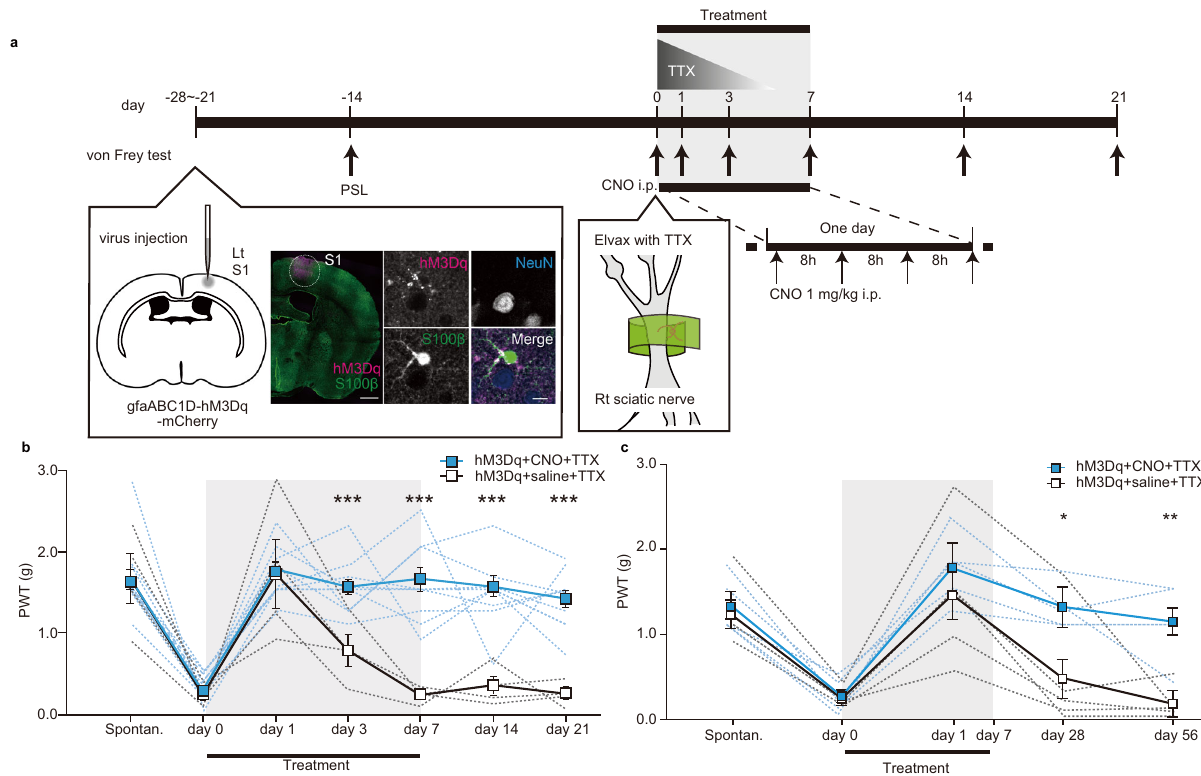
Fig. 2 Chemogenetic activation of targeting S1 astrocytes combined with transient nerve block reverses mechanical allodynia-like behaviour. a Schematic of the experimental schedule. The start of CNO-TTX (or control) treatment was designated as “ day 0 ” . Injection of gfaABC1D-hM3Dq- mCherry AAV into the PSL-contralateral S1 was performed between day − 28 to day − 21. Immunohistochemistry con fi rmed widespread expression (see Supplementary Fig. 6 for quanti fi cation) of hM3Dq (mCherry tag) in S1 astrocytes (S100 β staining) with no off-target expression in S1 neurons (NeuN staining). 1 mg/kg CNO (black bar) was injected at 8-hourly intervals from day 0 to day 7 (21 injections in total). PSL surgery, measurement of mechanical paw withdrawal thresholds (arrows), and TTX administration (graded triangle) were performed as in Fig. 1. Left fi gure scale bar = 500 μ m. Right fi gure scale bar = 10 μ m. b , c Graphs plotting mechanical paw withdrawal thresholds as mean ± SEM at various time-points before PSL (Spontan.) and before (day 0), during (day 1 – day 7), and after (day 8 onwards) the TTX with CNO treatment period (grey shading) or control TTX with saline treatment. For all graphs separately, statistical signi fi cance was tested using a two-way repeated measures ANOVA, followed by Bonferroni post hoc tests comparing treatment cohorts at each time-point, * p < 0.05, ** p < 0.01, *** p < 0.001. Source data are provided as a Source Data fi le. b Combined TTX with CNO